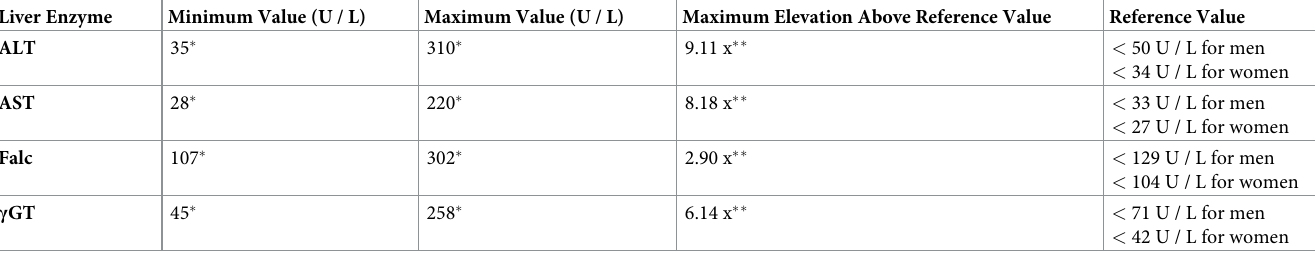
Table 1. Values of liver enzymes in patients using benznidazole for Chagas’s disease specific treatment.